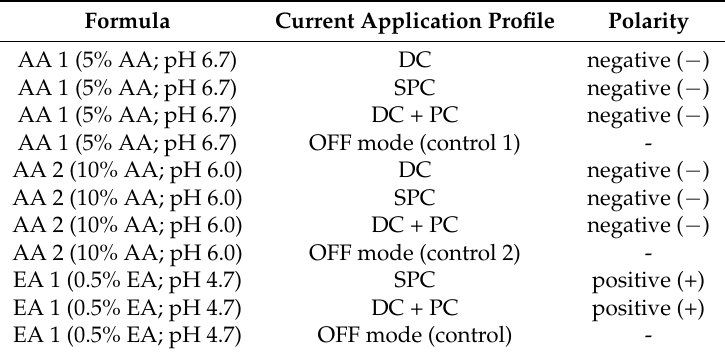
Table 2. Study design ( n =